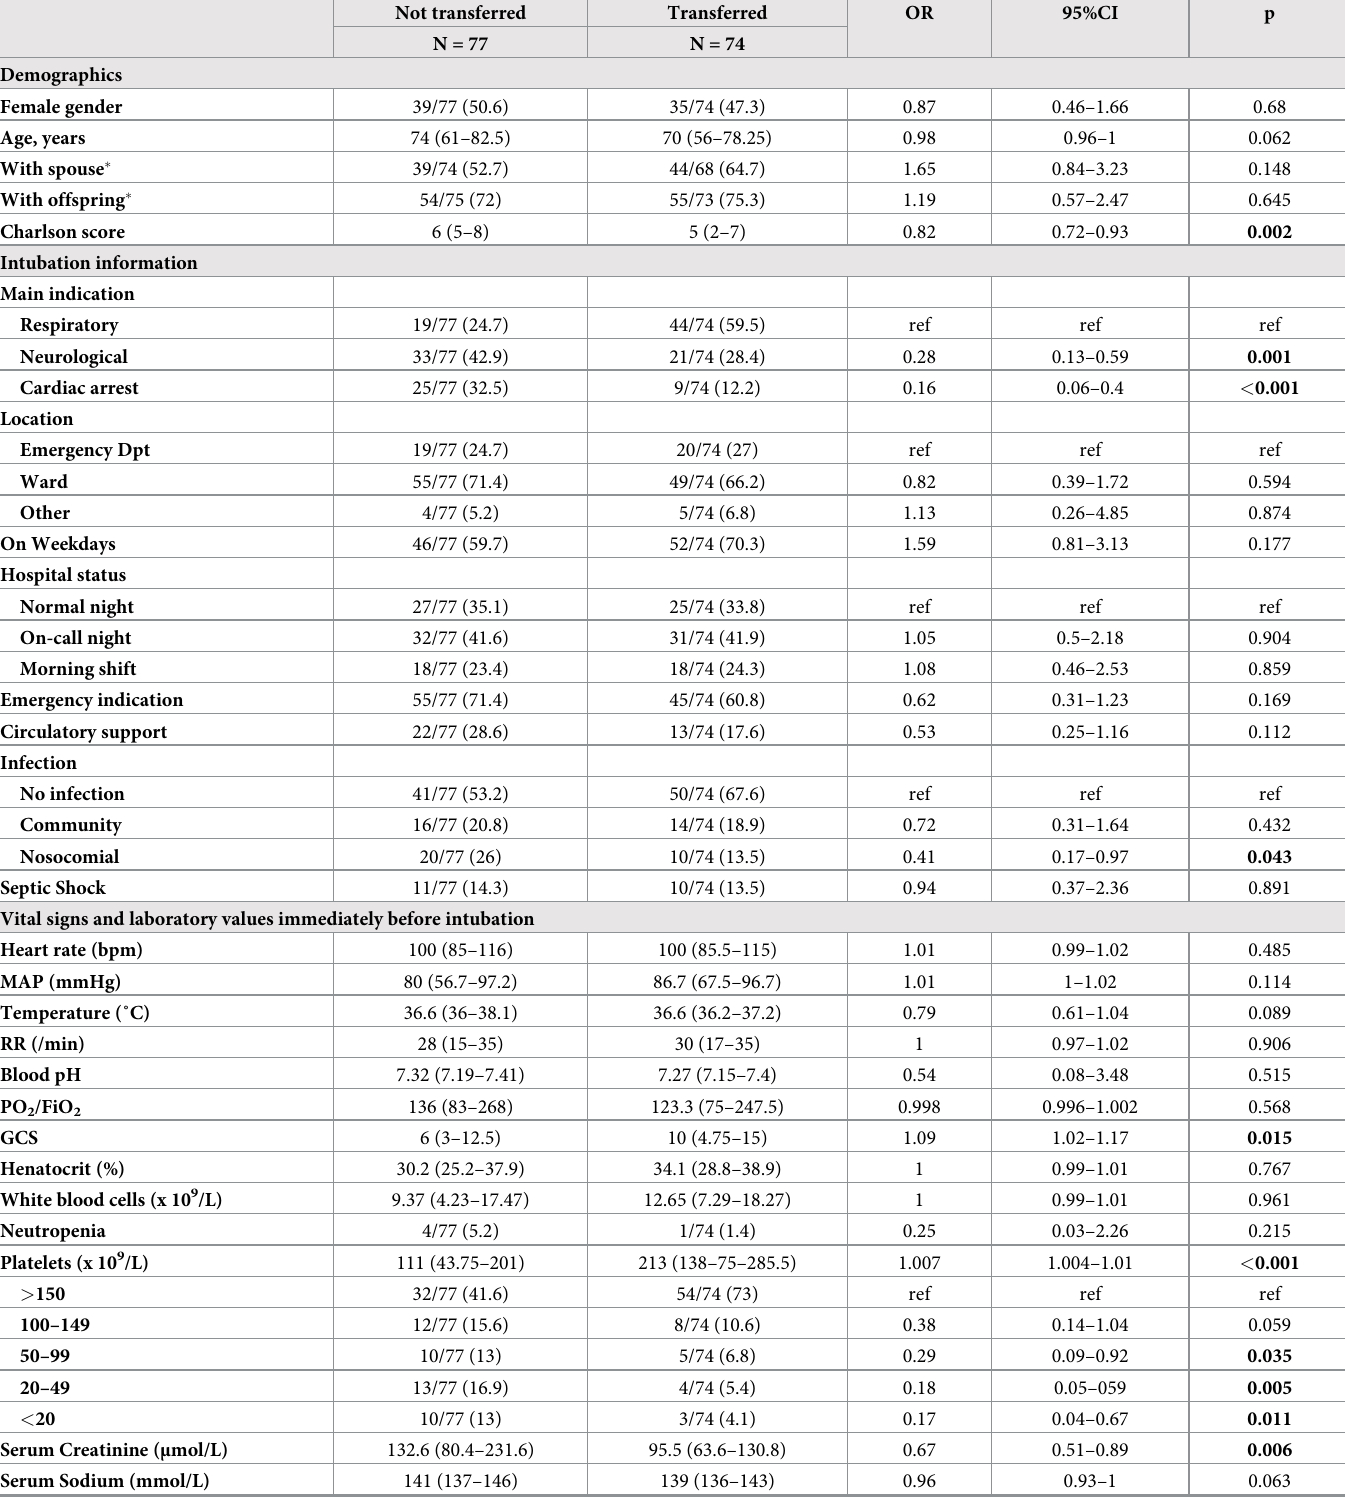
Table 3. Demographic, clinical, and laboratory characteristics of patients who were transferred and not transferred to ICU at the time of their intubation. Not